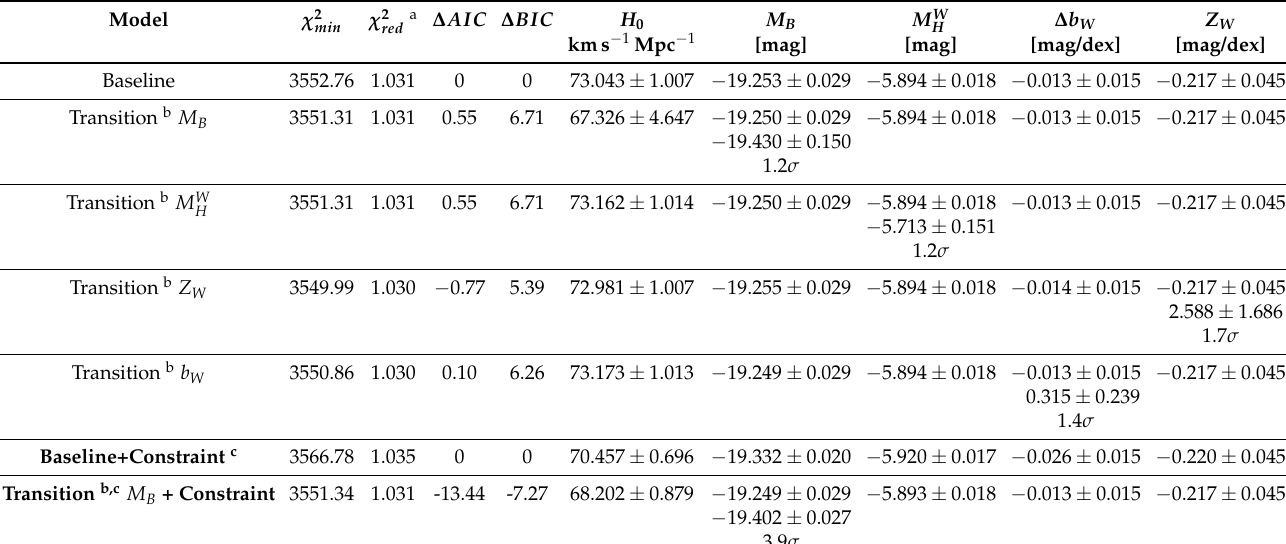
Table 4. A model comparison (baseline vs transitions) and best-fit parameter values in the absence (top five rows) and in the presence (last two rows) of the inverse distance ladder constraint. Notice that in the presence of the inverse distance ladder constraint and the transition degree of freedom, the best-fit value of H 0 is identical to the inverse distance ladder result of the completed SDSS-IV extended BAO survey